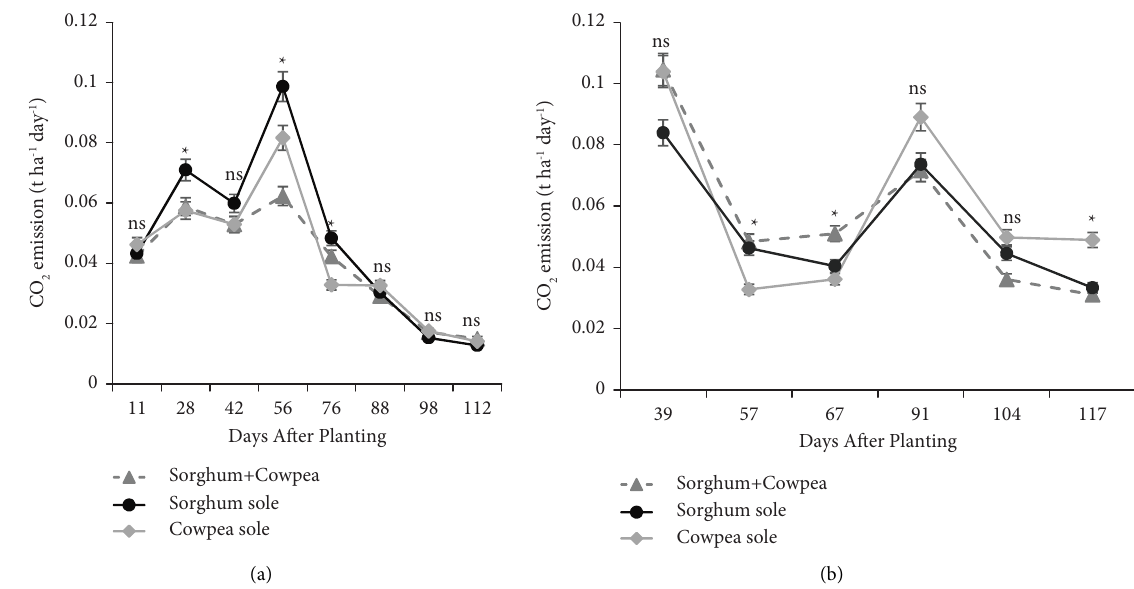
Figure 11: CO 2 emission rates of sorghum intercropped with cowpea, sorghum in sole and cowpea in sole cultures collected at Syferkuil during the 2018/19 (a) and 2020/21 (b) cropping seasons. ns � not signifcant; ∗ � signifcant at p ≤ 0.05.